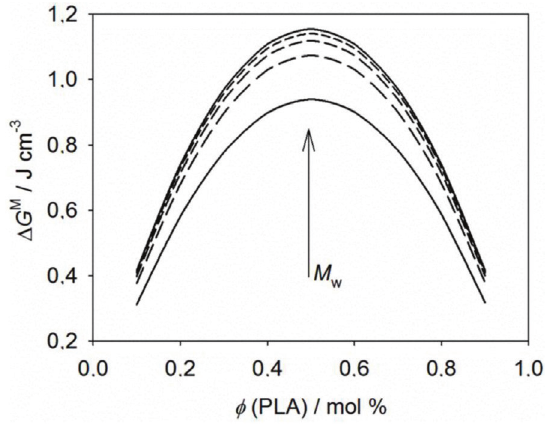
Fig. 1 – Gibbs energy of mixing for PLLA/PMMA blends with the increase in polymer molecular